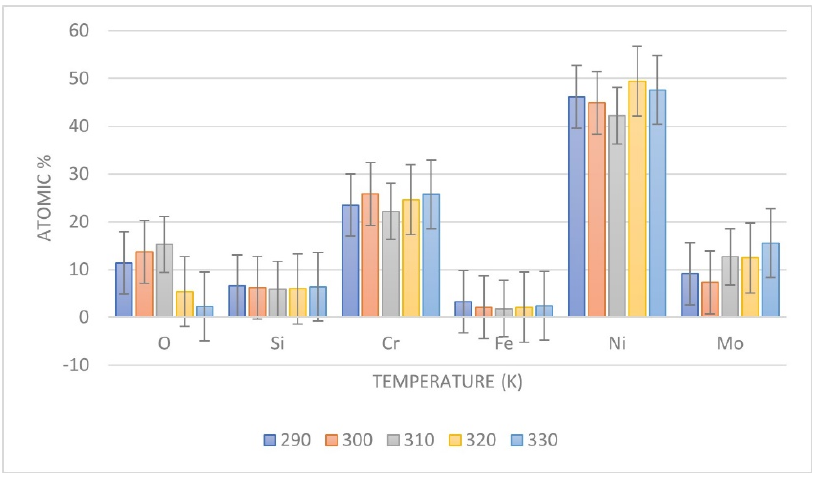
Figure 11. Elemental analysis for NiCr alloys after exposure in artificial saliva at different